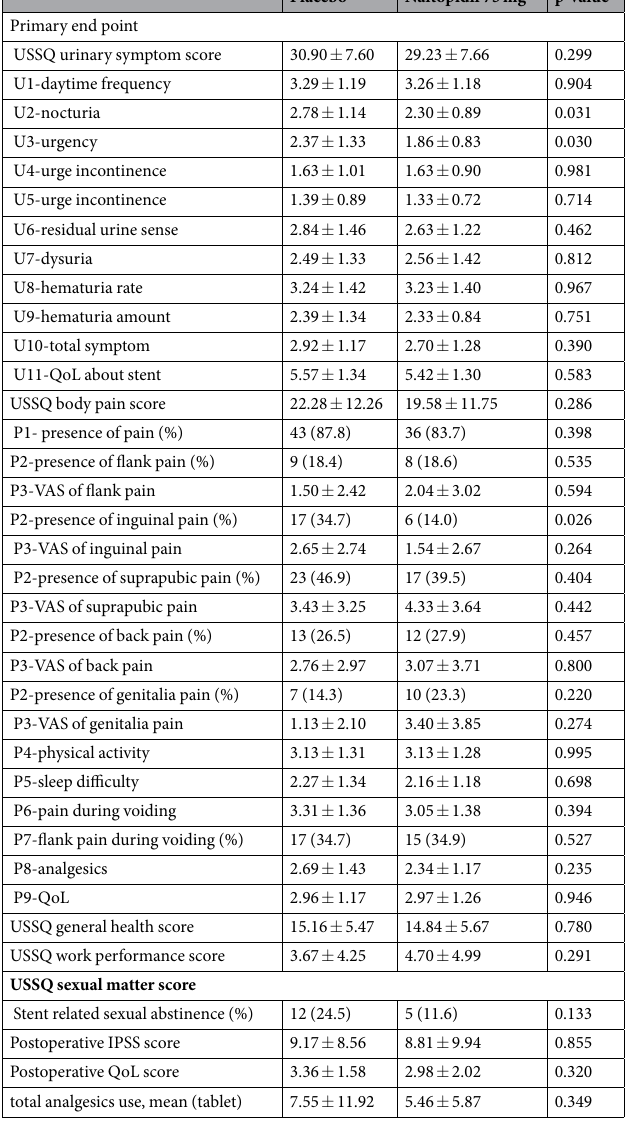
Table 2. Overall study results of primary end point and secondary end point. USSQ, Ureteral stent symptom questionnaire; IPSS, international prostate symptom score; QoL, quality of life; VAS, visual analogue